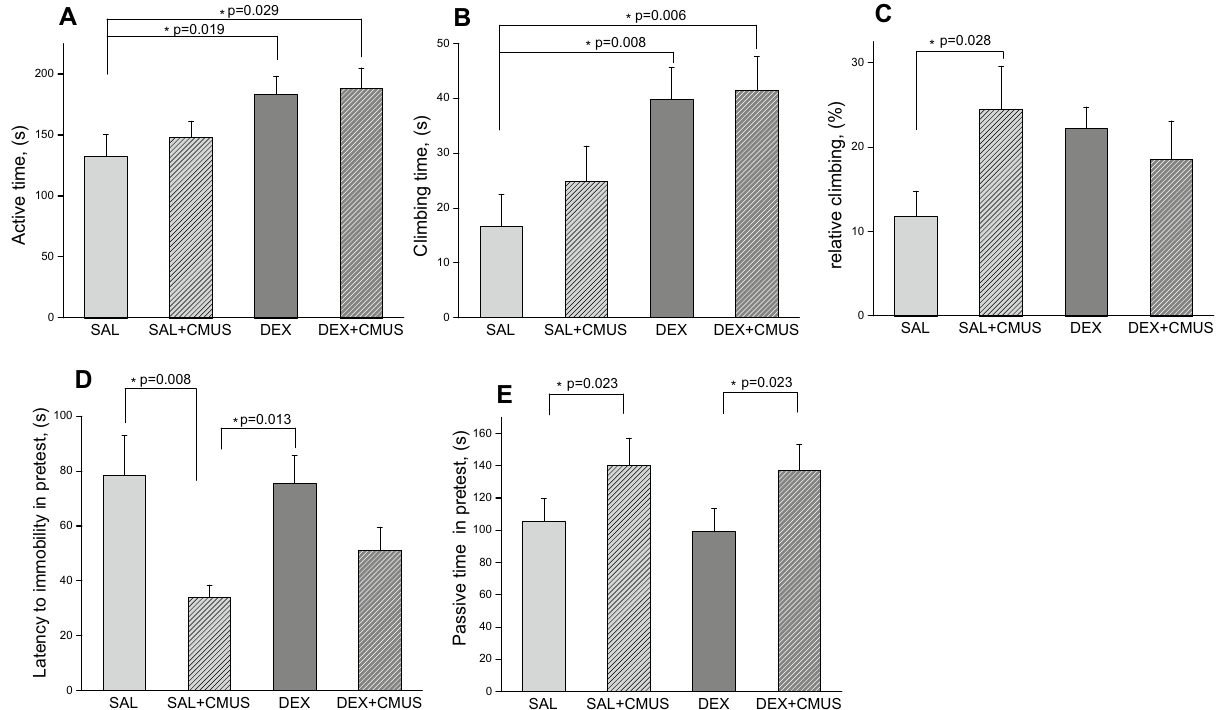
Figure 4. Depressive like behaviour and chronic mild unpredictable stress (CMUS) at late adolescence P45-60 on background of neonatal DEX administration on P2. ( A ) active swimming time in FST, ( B ) Climbing time, ( C )-Relative climbing time, ( D ) Latency to immobility in the pretest ( E ) Passive time in the pretest session. TWO WAY ANOVA,* p < 0.05, Data are presented as M ± SE.